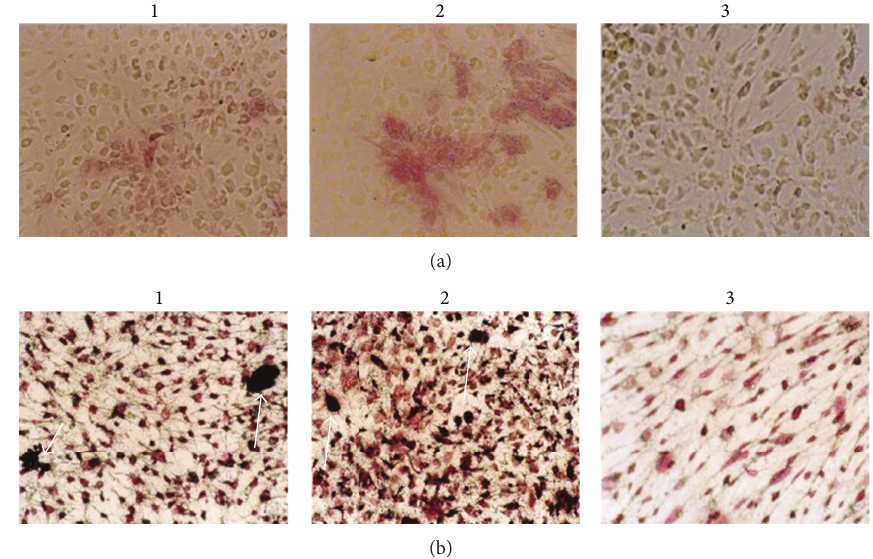
Figure 7: Histochemical analysis. C3H10T1/2 cells were plated into 40mm culture dishes for 2 days. Cells were then treated with 250 ng/mL Pf BMP-2 synthetic polypeptide or 1 𝜇 g/mL synthetic polypeptide of the knuckle epitope of human BMP-2 for the indicated time periods. (a) Staining for alkaline phosphatase was performed after 21 days. (b) von Kossa staining at 21 days. 1: the Pf BMP-2 synthetic polypeptide; 2: the synthetic polypeptide of the knuckle epitope of human BMP-2; 3: control culture. The white arrows indicate the areas of calcification. Cells were photographed at 100x